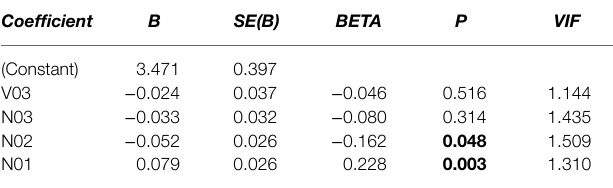
TABLE 8 | Multiple regression with ICL und cognitive abilities ( n =